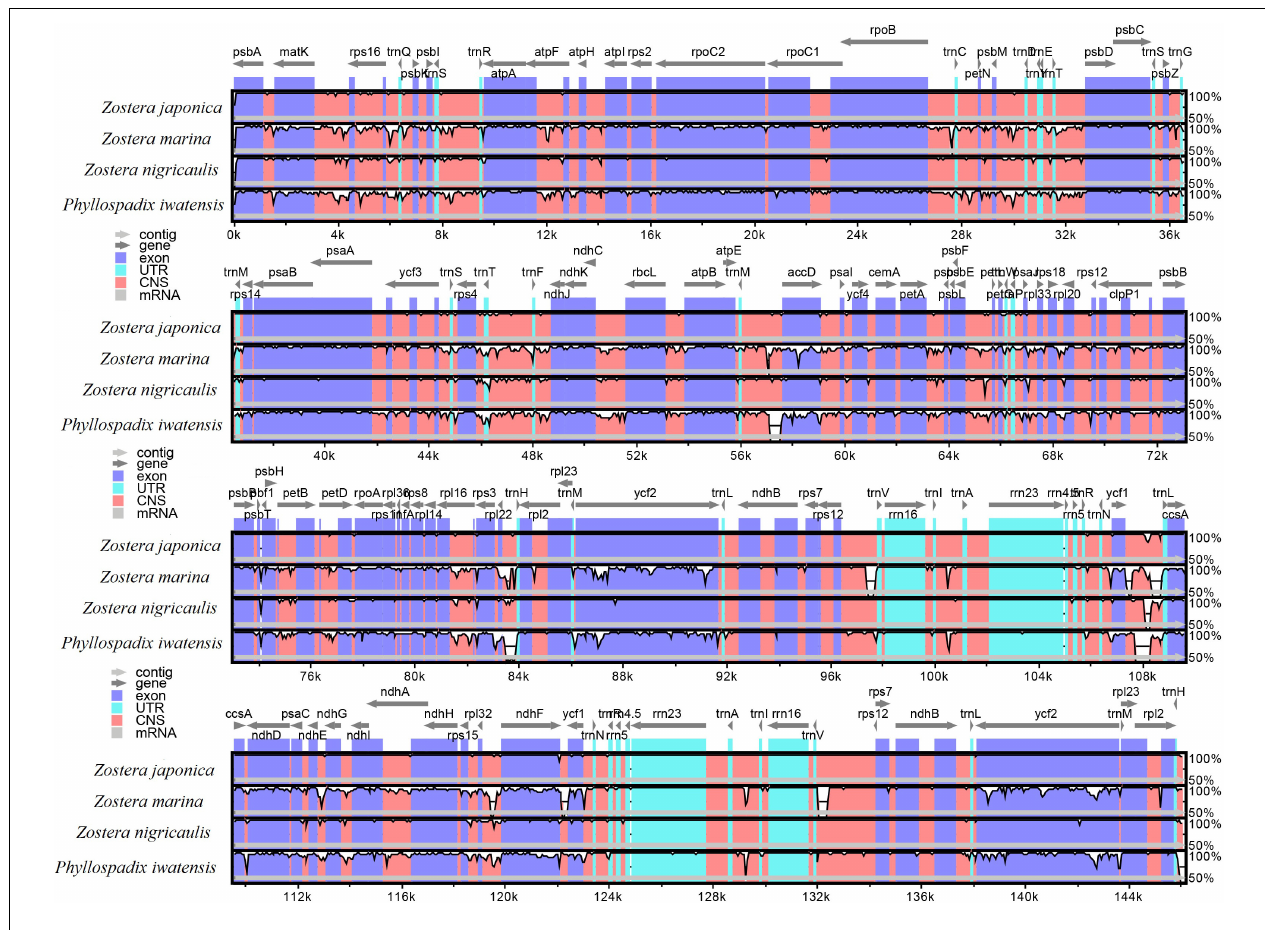
FIGURE 3 | Sequence identity plots based on four Zosteraceae